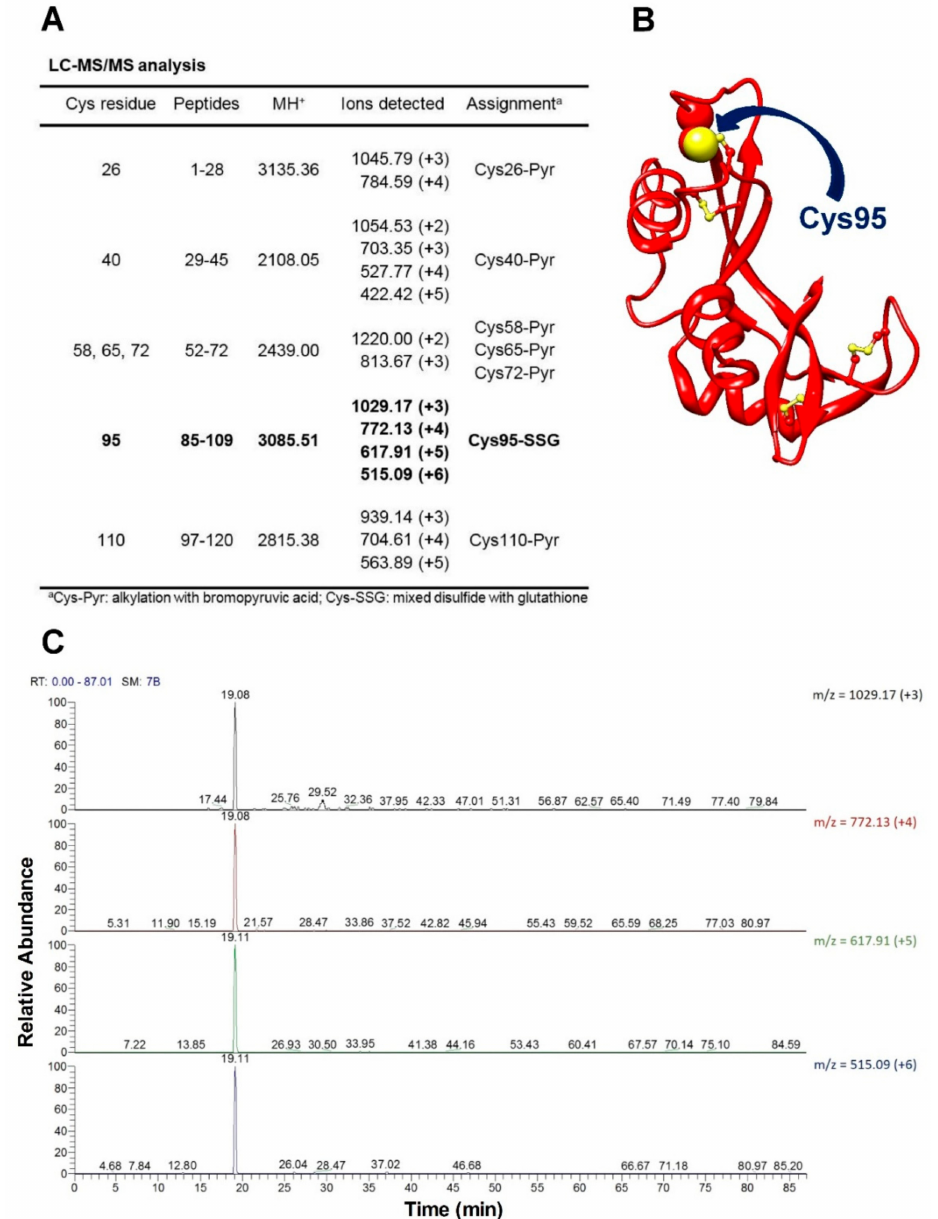
Figure 7. Mass spectrometry identification of the most reactive cysteine of the rRNase toward GSSG. ( A ) Cys-containing peptides identified in the LC-MS / MS analysis of controlled pepsin hydrolysis of the rRNase treated with 0.4 mM GSSG at pH 7.4 for 10 s and then alkylated with 1 mM bromopyruvic acid. ( B ) Three-dimensional structure of native RNase A from bovine pancreas (PDB id: 1FS3) [21] represented in red ribbons; cysteines are in yellow ball-and-stick, the most hyper-reactive cysteine (Cys95) is highlighted by a yellow sphere and indicated by the blue arrow. The picture was drawn by using UCSF Chimera [22]. ( C ) Ion-extraction chromatograms of the tri-, four, five-, and six-fold charged ions corresponding to the 85–109 peptide containing the glutathionylated